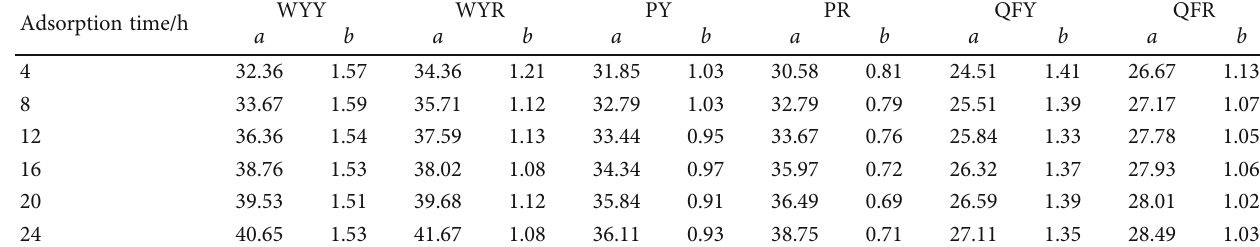
Table 5: Methane adsorption constants of di ff erent coal samples in di ff erent adsorption time. Adsorption time/h